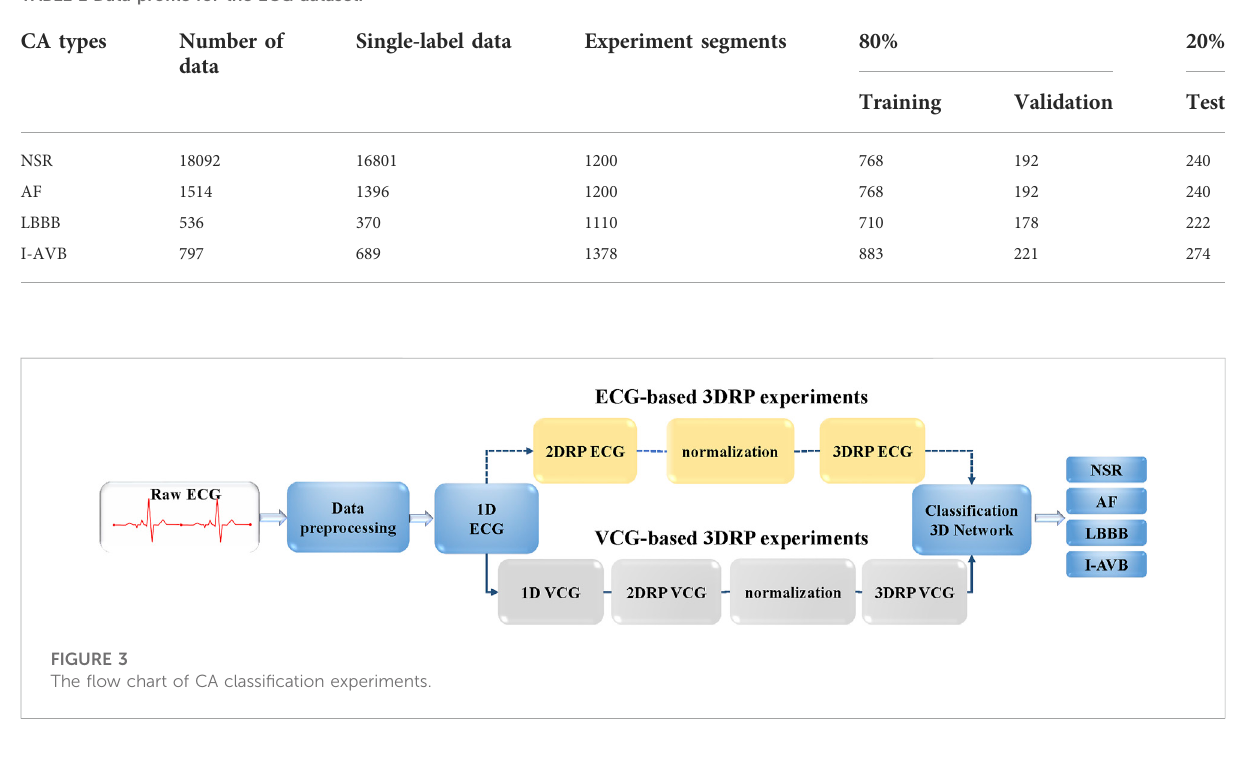
TABLE 1 Data pro fi le for the ECG dataset.